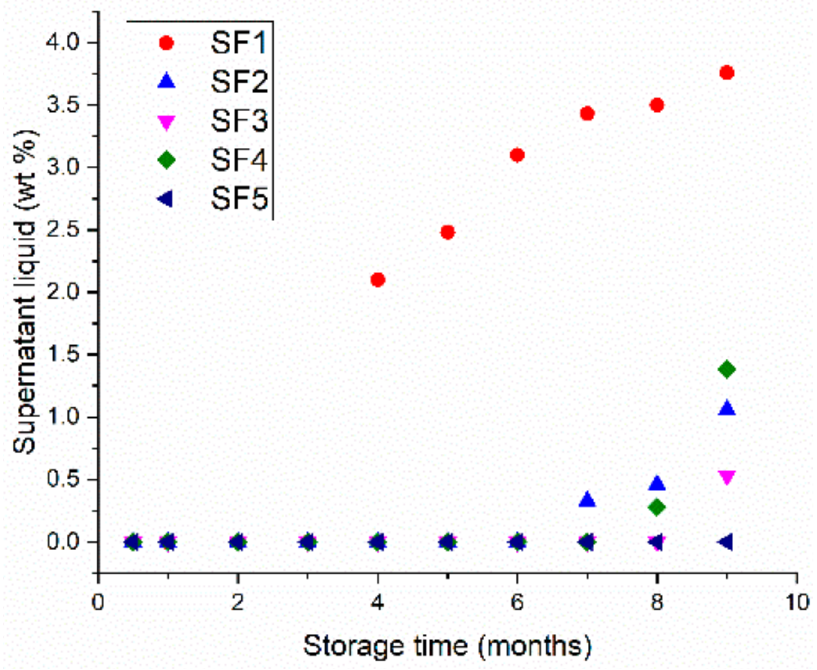
Figure 5. Weight percentage of supernatant as a function of storage time for CBR gels with 1–5 wt.% surfactant (SF1–SF5).